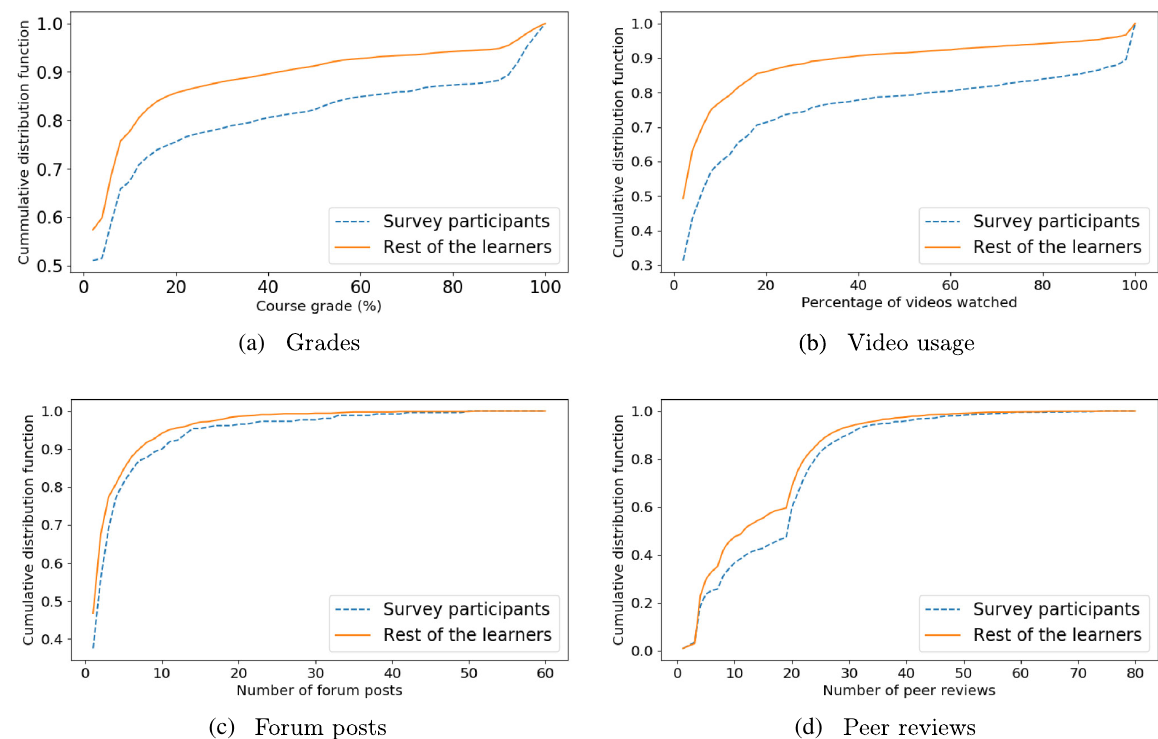
FIG. 2. Cumulative distribution functions for the (a) grades, (b) percentage of videos watched, (c) number of forum posts, (d) number of peer reviews for survey participants (dashed line) and for the rest of the learners in the course (solid line).